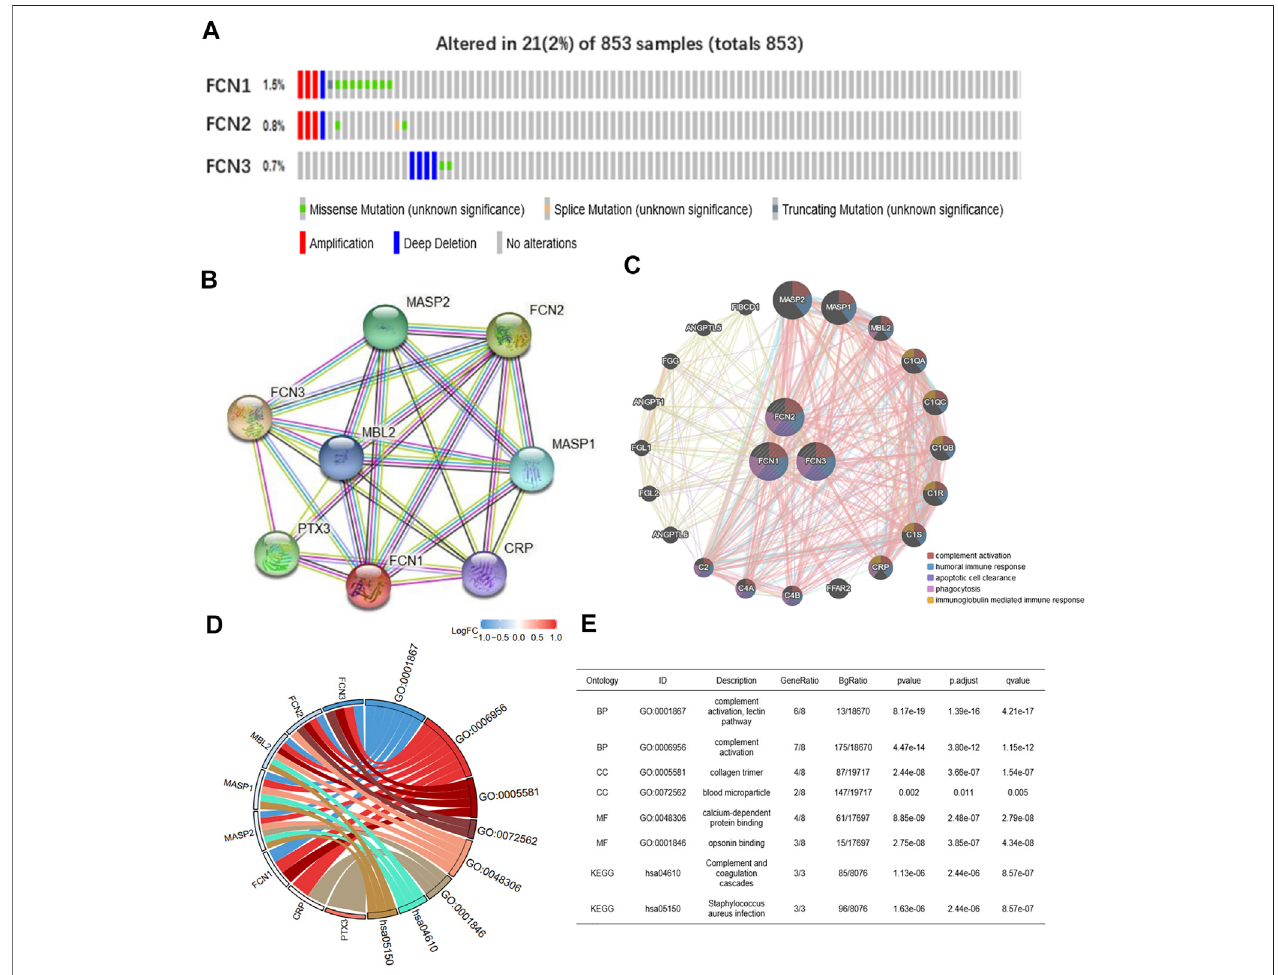
FIGURE6| FCNs genemutationand PPInetworkconstraction. (A) Summaryofalterations indifferentexpressed FCNsinLIHC.FCNswerealtered21samplesof 853 patients with LIHC, accounting for 2%. (B,C) Protein-protein interaction network of different expressed FCNs. (D,E) GO and KEGG analysis of the FCNs and correlation